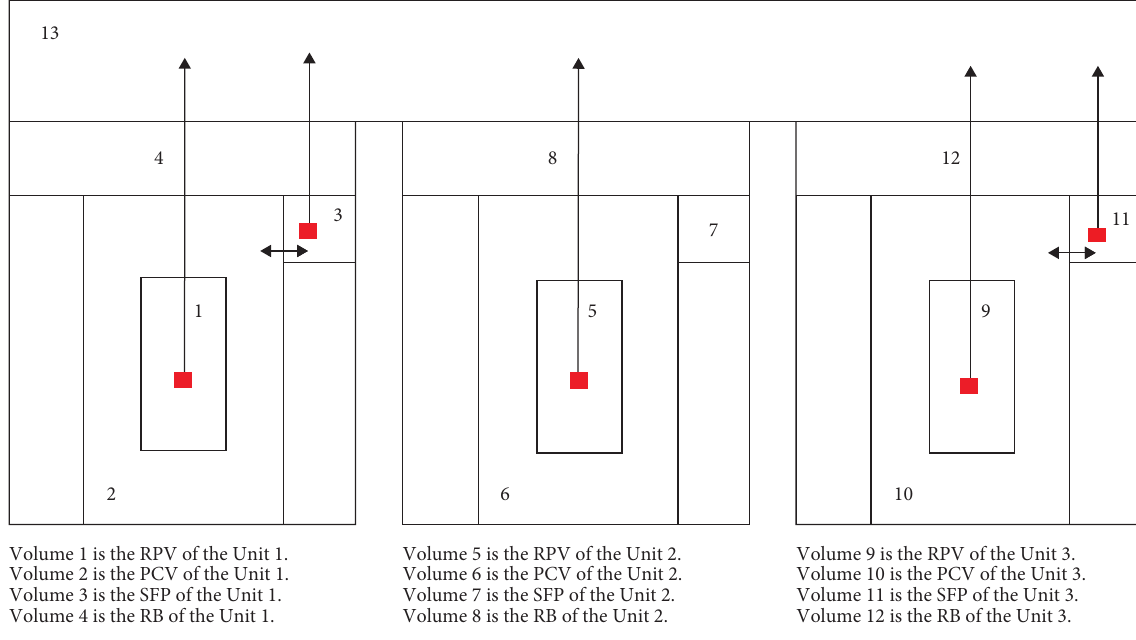
Figure 10: Nodalization and flow directions of case 3.